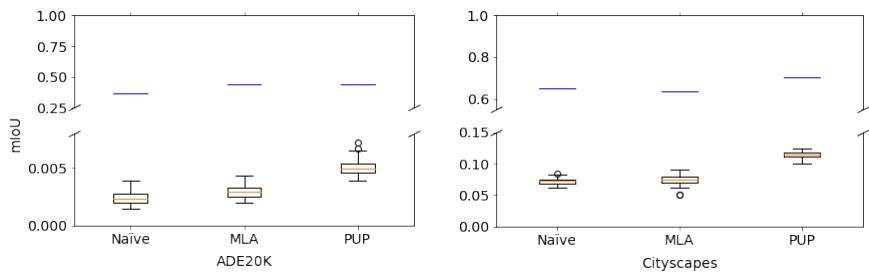
Figure 6. Mean IoU ( mIoU ) values of protected models with randomly generated 50 keys. Boxes span from first to third quartile, referred to as Q 1 and Q 3 , and whiskers show maximum and minimum values in range of [ Q 1 − 1.5 ( Q 3 − Q 1 ) , Q 3 + 1.5 ( Q 3 − Q 1 ) ]. Band inside box indicates median. Outliers are indicated as dots. Blue lines represent each